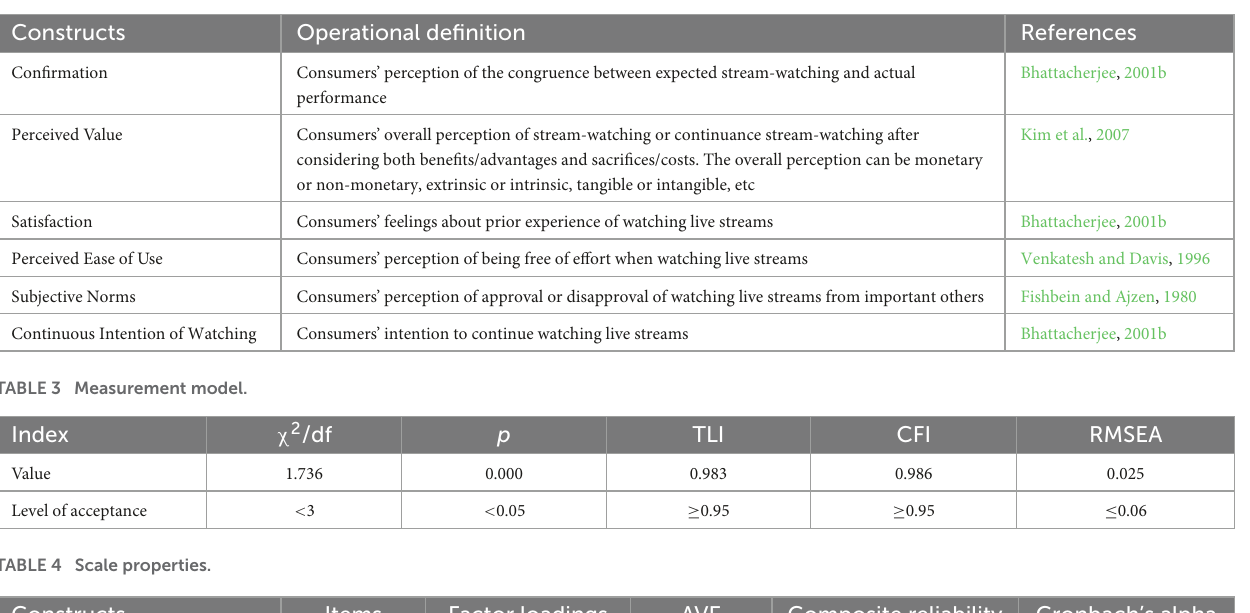
TABLE 2 Operationalization of the constructs.